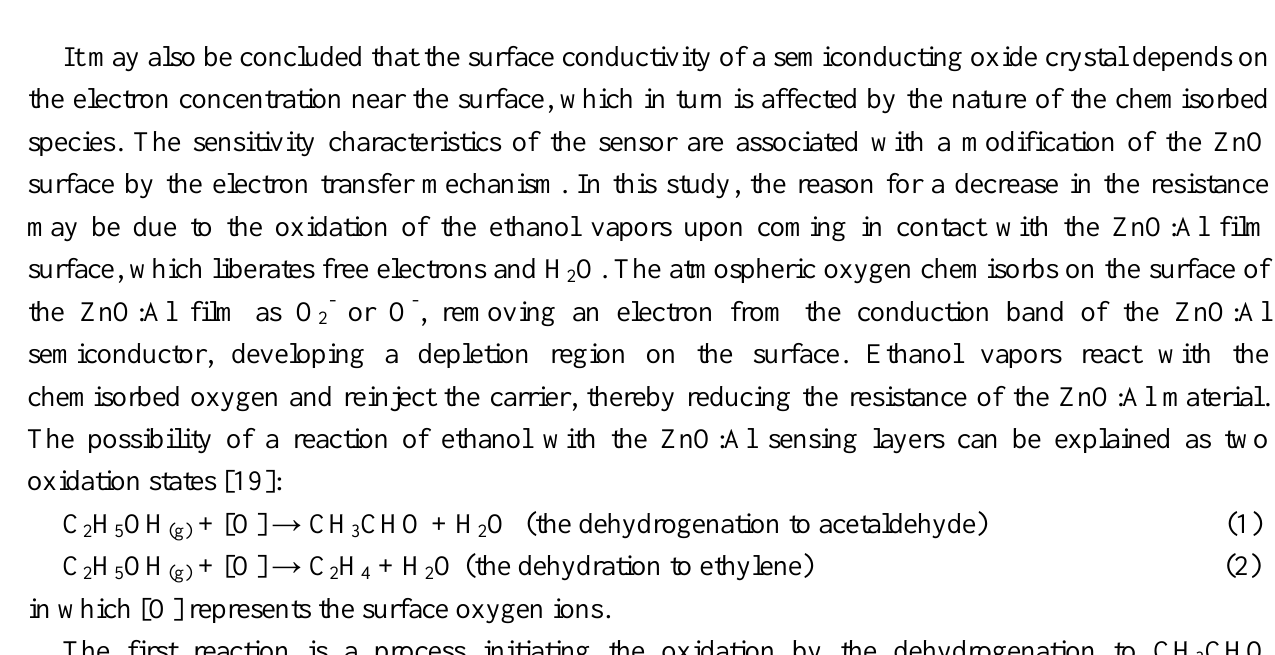
Figure 5. Sensitivity variation as a function of ethanol concentration for ZnO:Al thin film as operated at 250 ℃